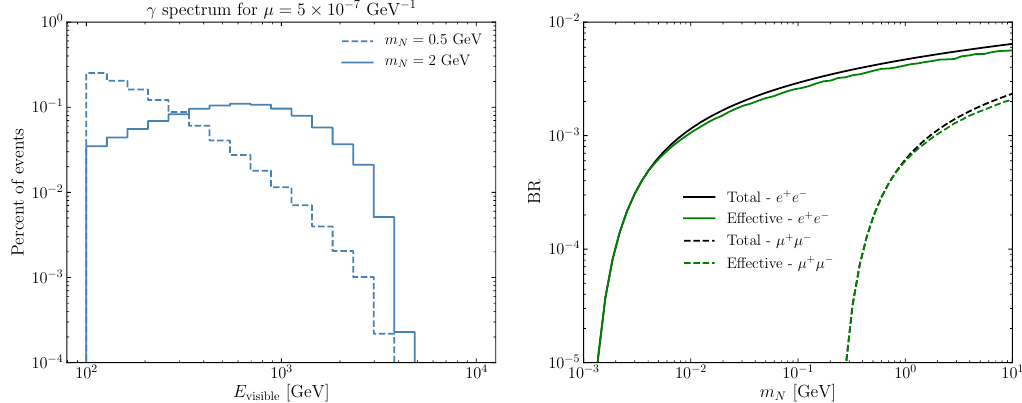
Figure 2 . The results for the model with the dipole portal to HNLs and the universal coupling µ N . Left : the energy spectrum of photons coming from the HNL decays in the FASER decay vessel for the benchmark values of the model parameters as indicated in the plot. Right : the branching fraction into three-body decays, N → ν ( γ ∗ → ‘‘ ) , where ‘ = e (solid black line) or µ (dashed black), as a function of the HNL mass m . The green solid (dashed) lines correspond to a slightly N lower “effective” branching fraction that takes into account the analysis cut on the visible energy, E vis > 100 GeV , for the electrons (muons) in the final state. These lines assume that the parent HNL energy is equal to E = 1 TeV N